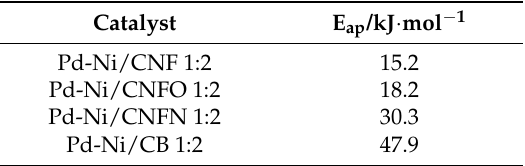
Figure 11. Arrhenius plots for the synthesized Pd-Ni catalysts. Table 5. Methanol oxidation apparent activation energies for the synthesized Pd-Ni catalysts.